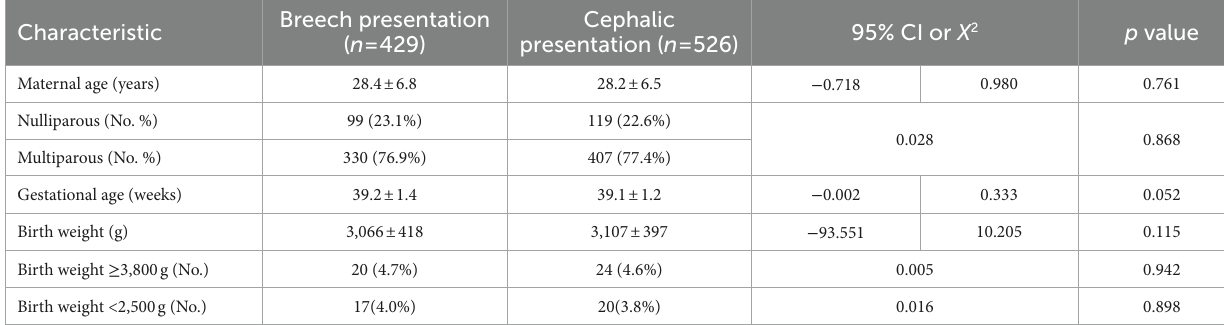
TABLE 2 Characteristics between term breech and cephalic delivery in the study.